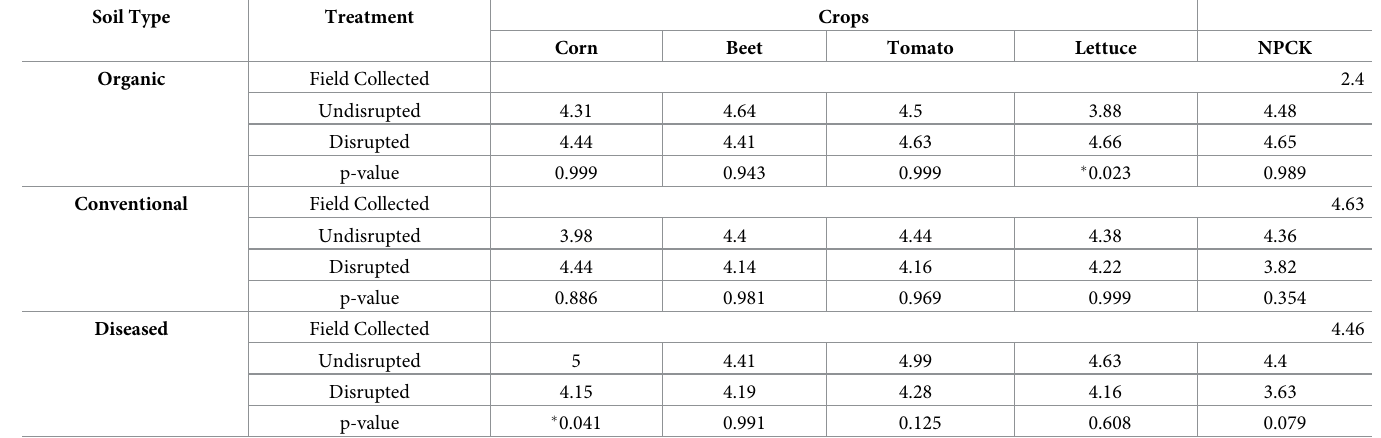
Table 2. Shannon’s diversity index. Shannon’s diversity index values were recorded for all samples and determined using the R’s vegan package (Vers. 25–6). (NPCK = No plant controls). Soil